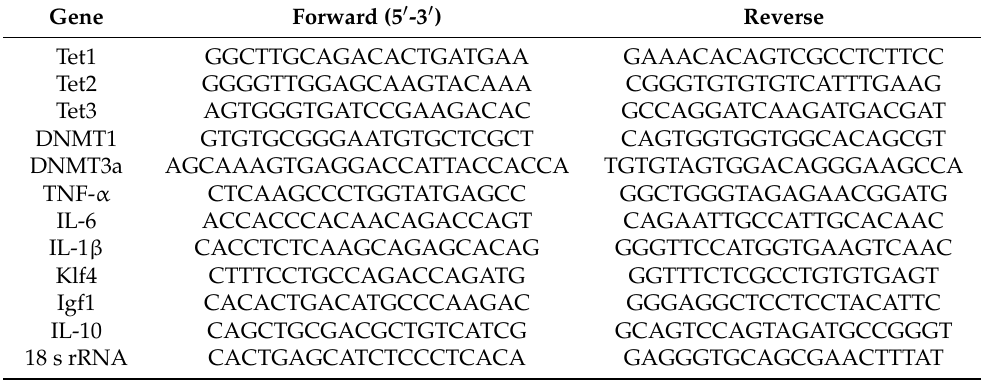
Table 1. Primer sequences used for real-time PCR gene expression analysis.